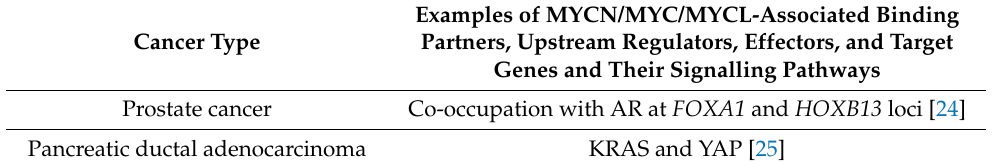
Table 1. Examples of MYC-associated partners, upstream mediators, or target genes and the malig- nancies in which they have been